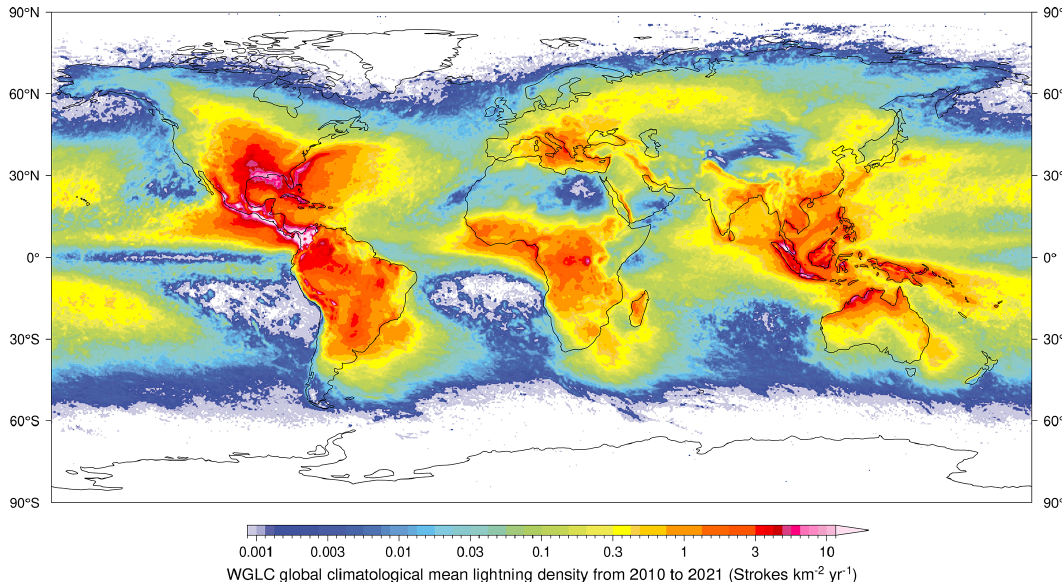
Figure 2. Climatological mean annual lightning stroke density (2012–2021).